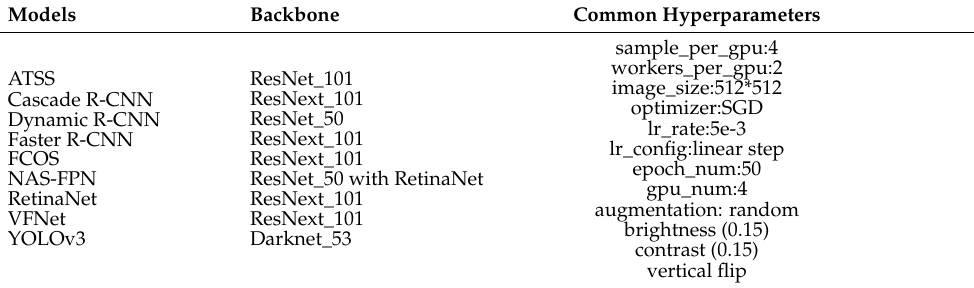
Table 3. Hyperparameter settings for the